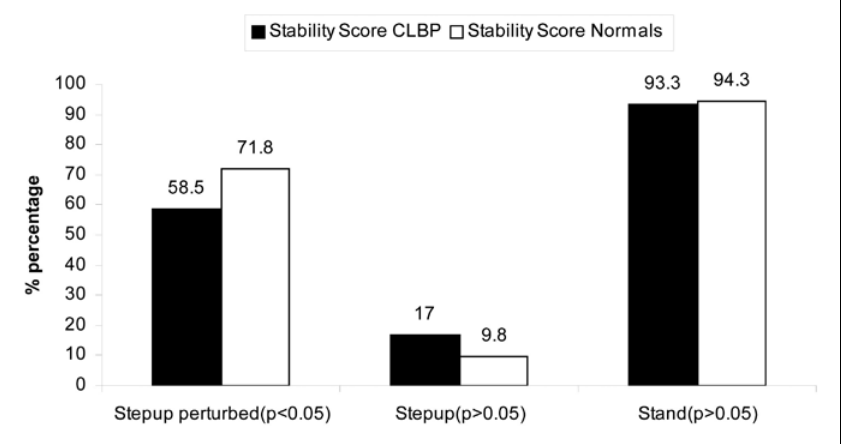
Figure 5: Stability scores (%) during step-up with perturbation, step-up and quiet standing task in clBP and healthy participants with independent ‘t’ test